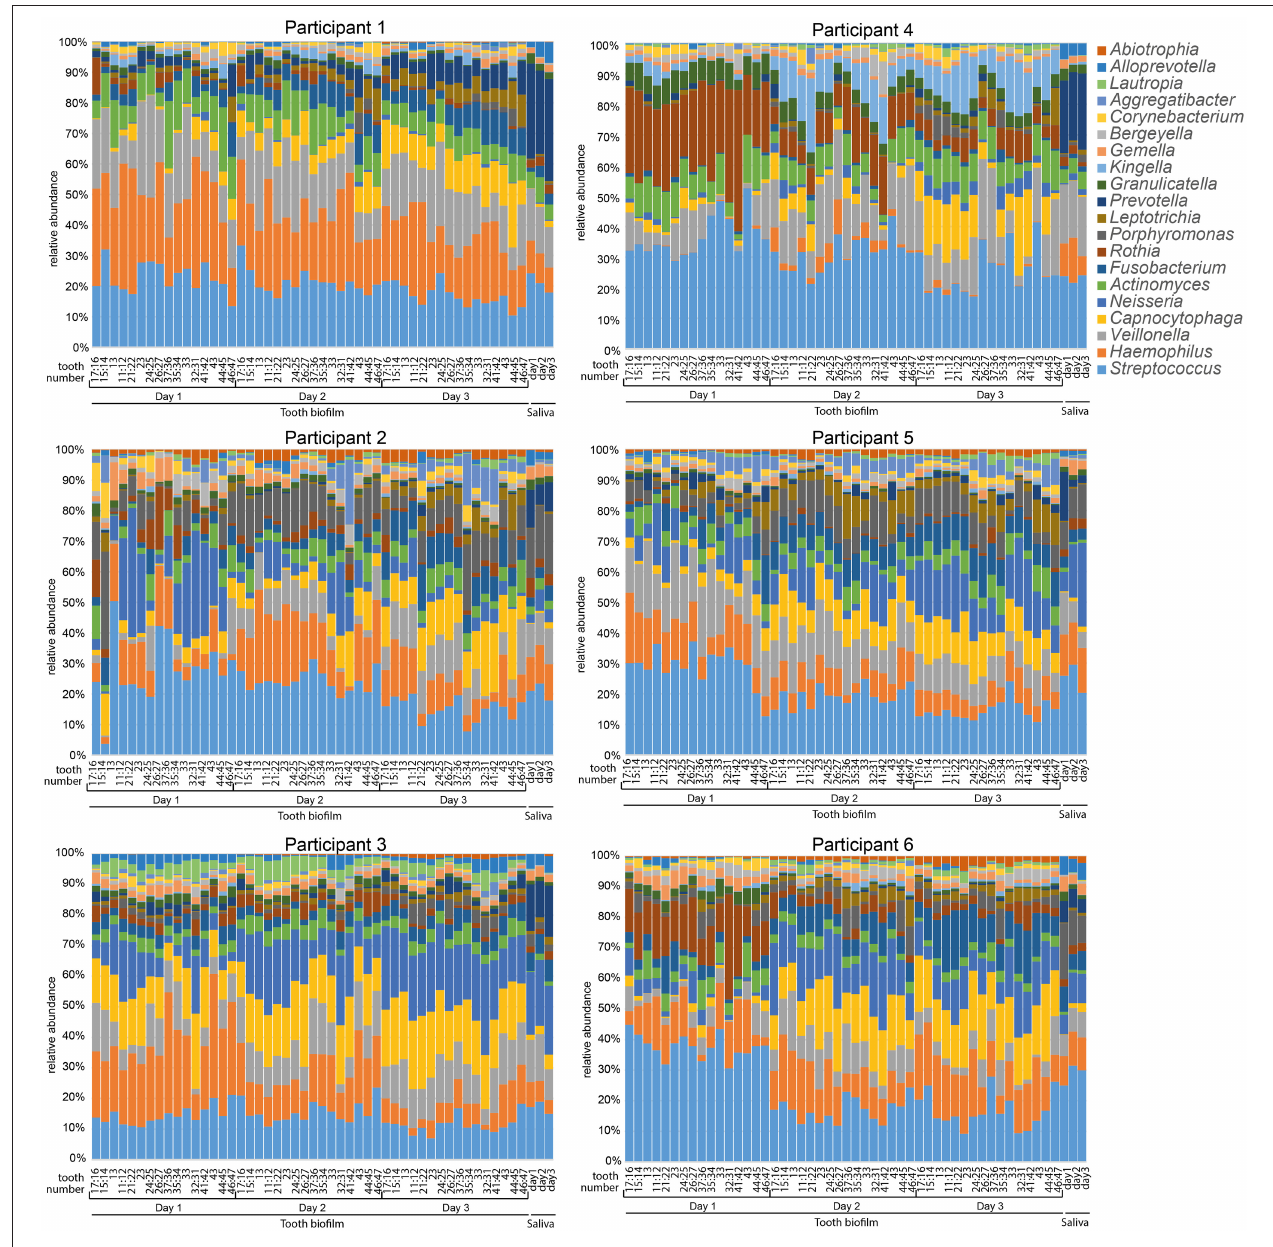
FIGURE 1 | Stacked bar graphs illustrating microbiota profiles in saliva and 16 selected tooth regions after 1, 2, or 3 days without oral hygiene (accumulation time). Data are shown for each of the six participants and the labels at the bottom of the figures indicate sample type, teeth sampled for the 16 tooth regions, and days without oral hygiene. Tooth numbers are given according to the FDI World Dental Federation notation system. The y -axis shows the relative proportion (%) for the top 20 detected genera. The colors in the figures match the colors for the genus in the list to the